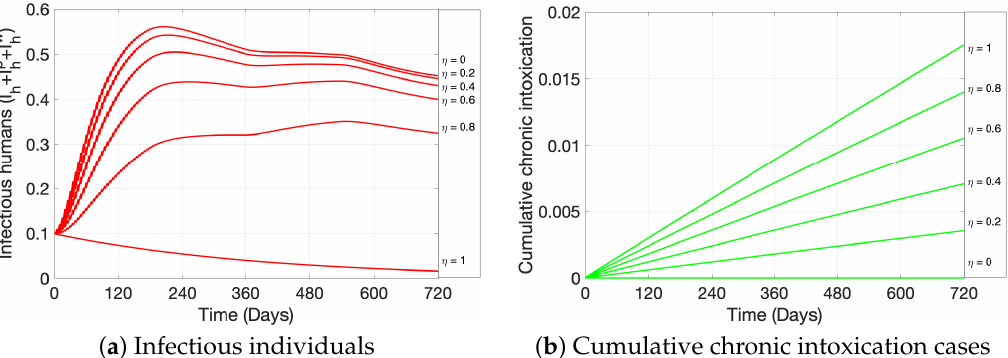
Figure 5. The figure shows the effect of ITN coverage η = 0,0.2,0.4,0.6,0.8,1 on ( a ) point prevalence of malaria-infected humans and ( b ) cumulative chronic intoxication cases after a prolonged exposure to ITNs. All other parameter values used are as in Figure 4.